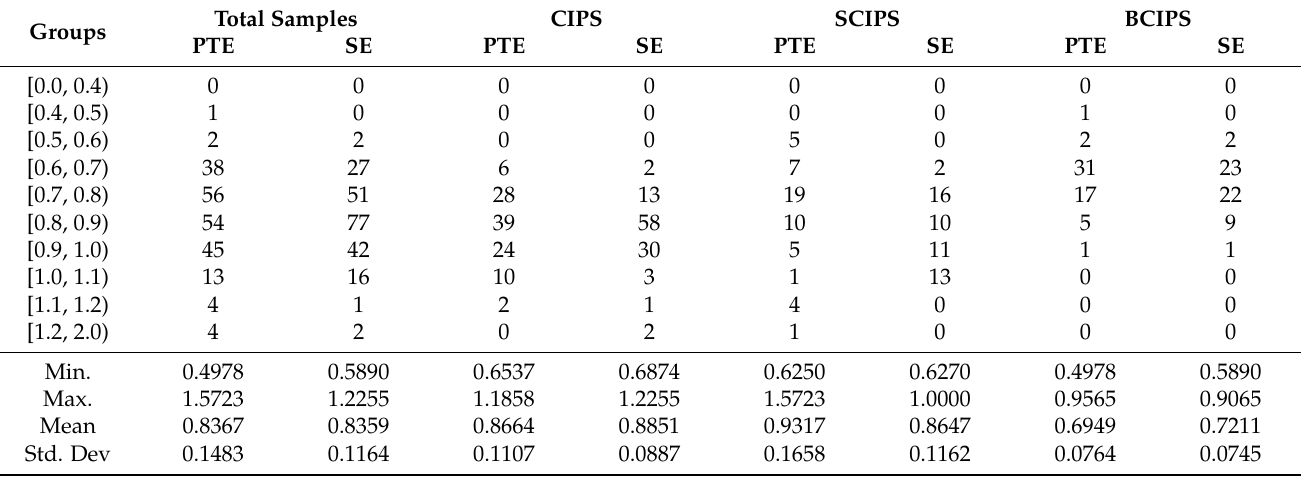
Table 4. The Pure Technical Efficiency (PTE) and Scale Efficiency (SE) of Different Beef Calf Production Systems Calculated by the VRS-DEA Model.